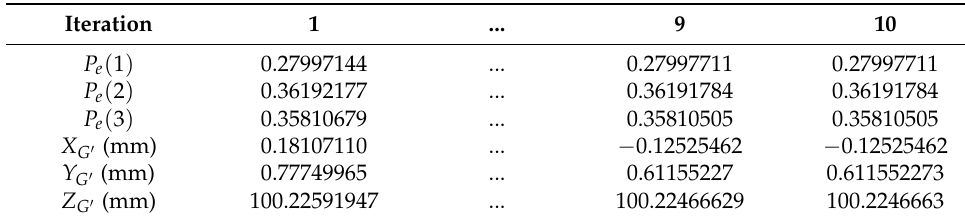
Table 16. Results of first experiment.